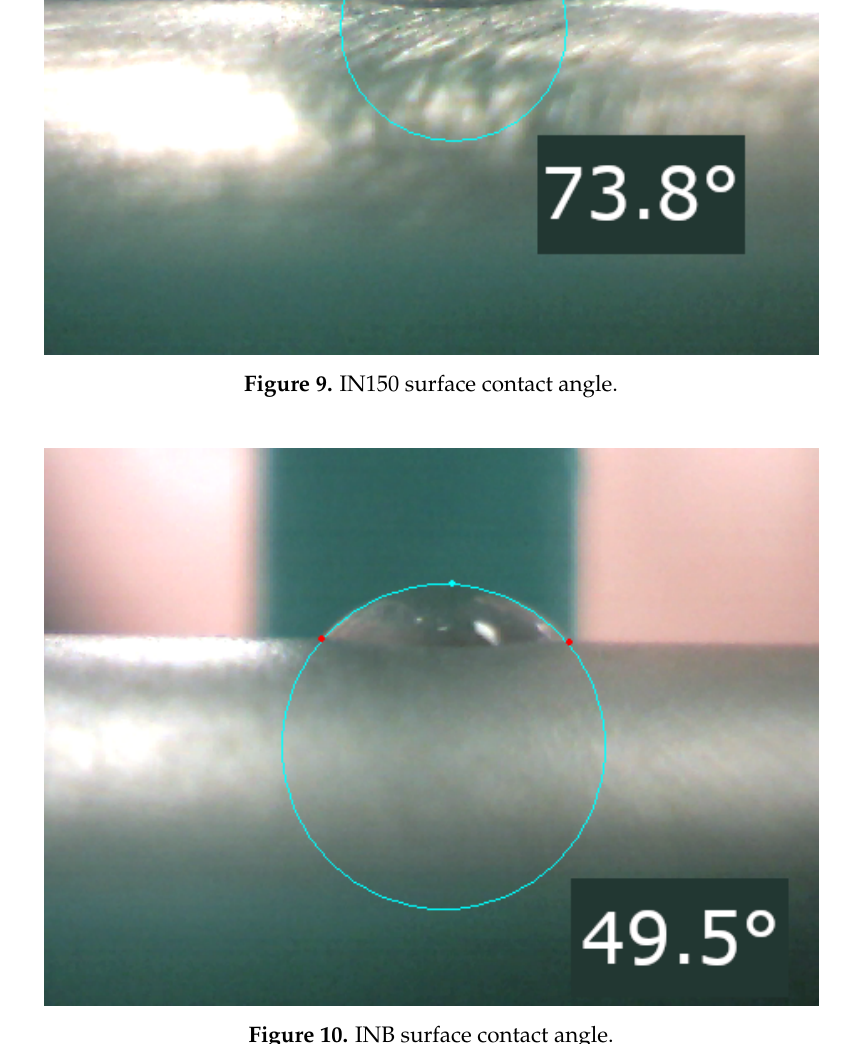
Figure 10. INB surface contact